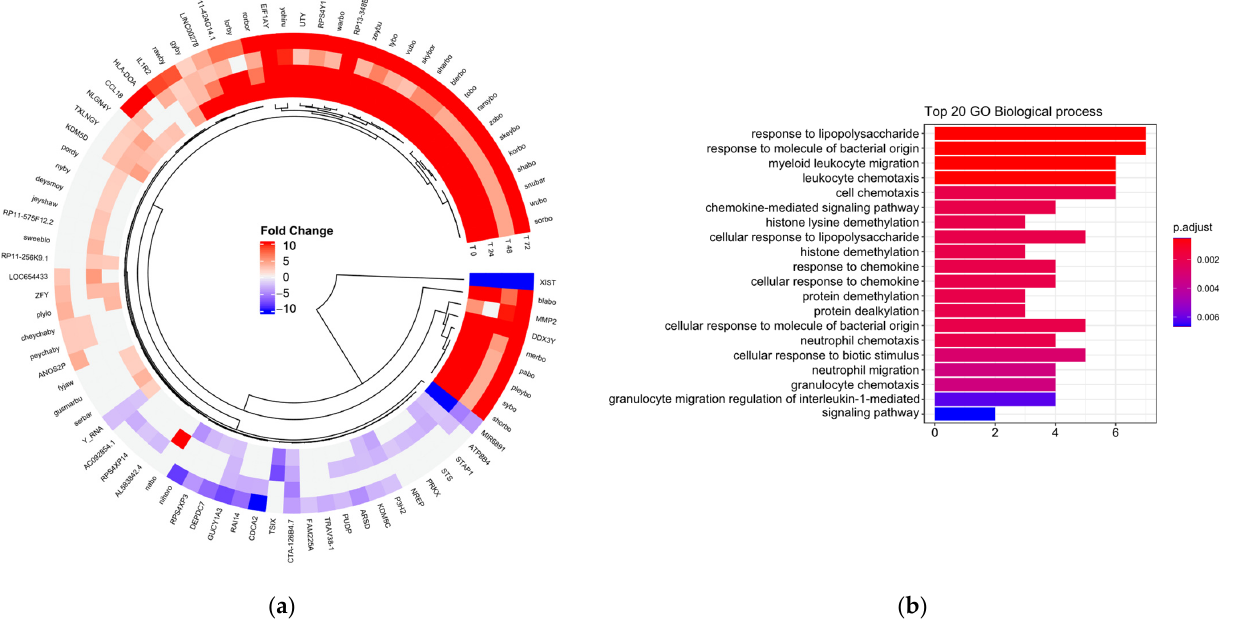
Figure 1. ( a ) Circular heat map representation of unsupervised hierarchical clustering from analysis of different time (rows) grouped by gene (columns). The red tones indicate upregulation and blue tones, downregulation. ( b ) Gene ontology (GO) enrichment between men and women. Top 20 significantly enriched GO. p .adjust (adjusted p ‐ value): Red < purple < blue. Graphs were plotted using Database for Annotation, Visualization, and Integrated Discovery (DAVID) online tool version 6.8.